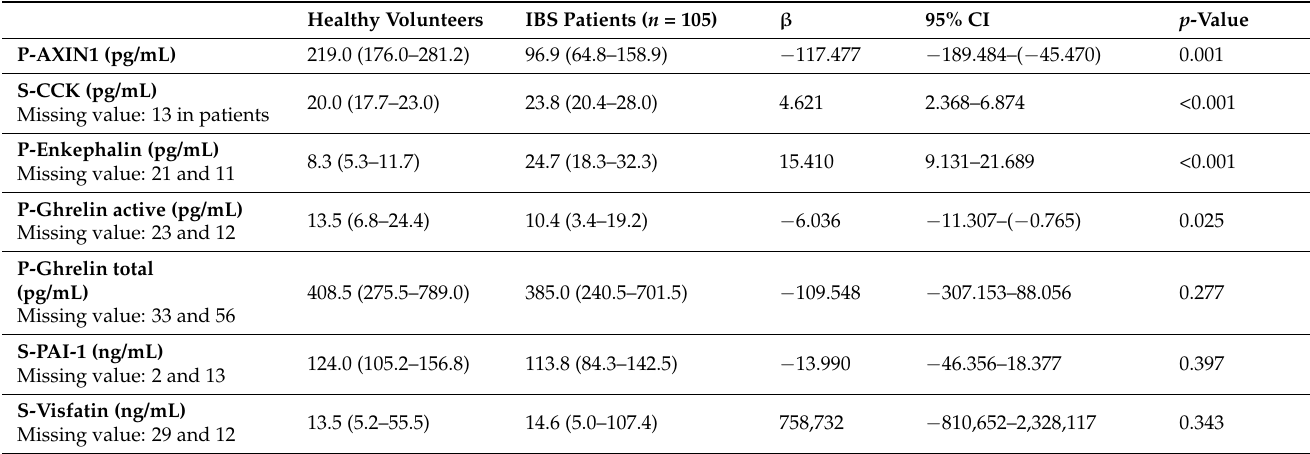
Figure 4. Basal levels (pg/mL) of AXIN1, cholecystokinin (CCK), enkephalin, and active ghrelin in healthy volunteers and IBS patients at baseline. Mann–Whitney U-test. p < 0.05 was considered statistically significant. Table 5. AXIN1 and hormone levels in IBS patients and healthy volunteers at baseline.